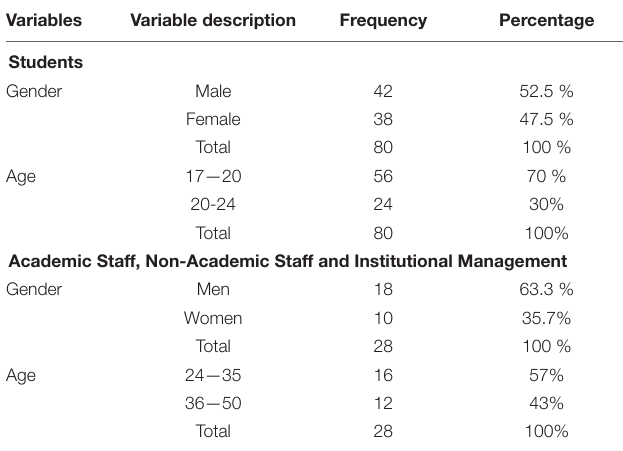
TABLE 2 | Distribution of respondents based on gender and